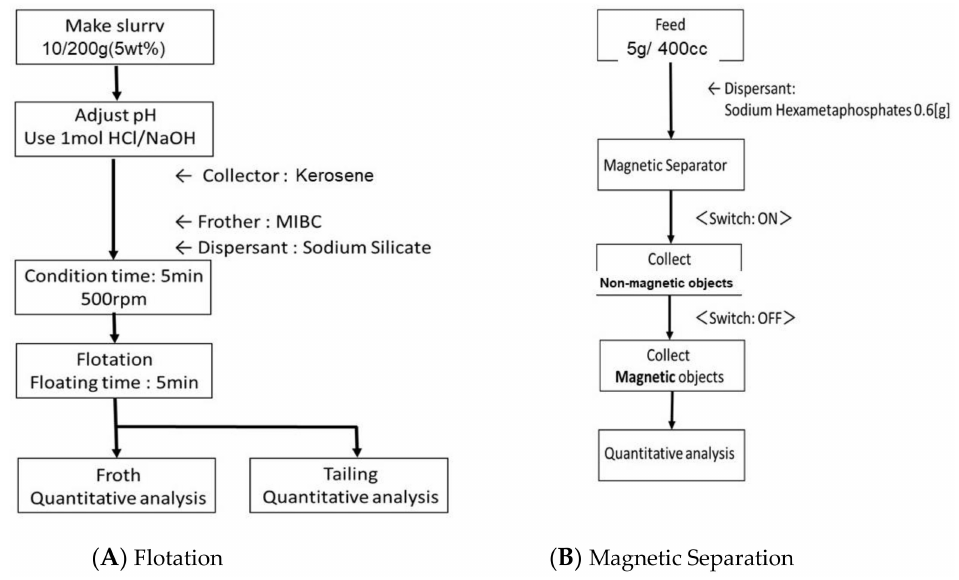
Figure 6. Flowsheet of mineral processing with flotation ( A ) and magnetic separation ( B